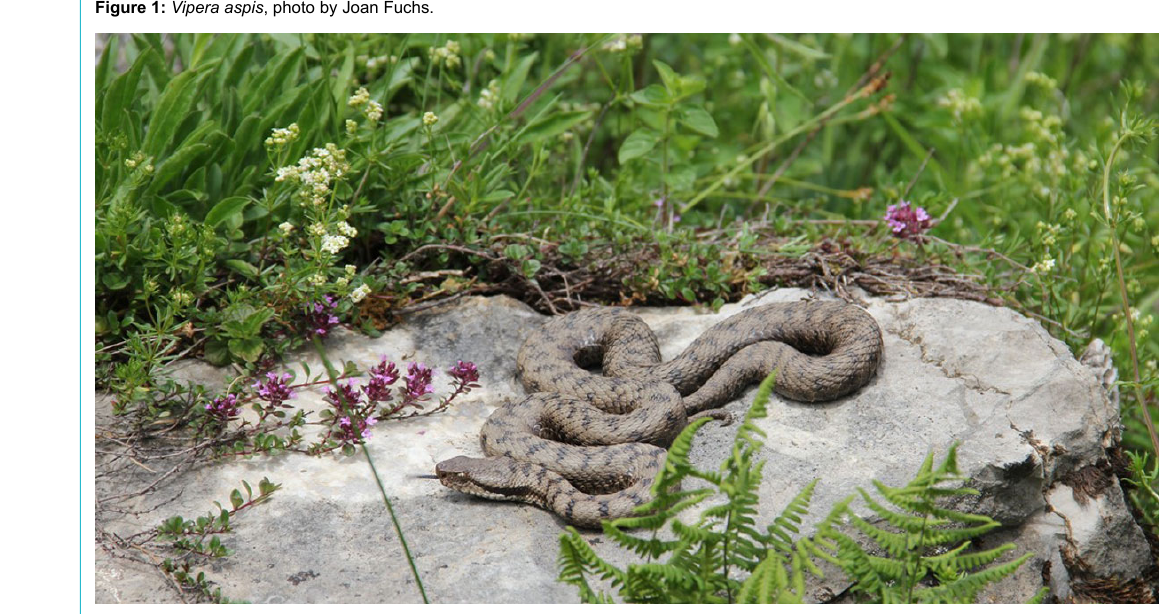
Figure 1: Vipera aspis , photo by Joan